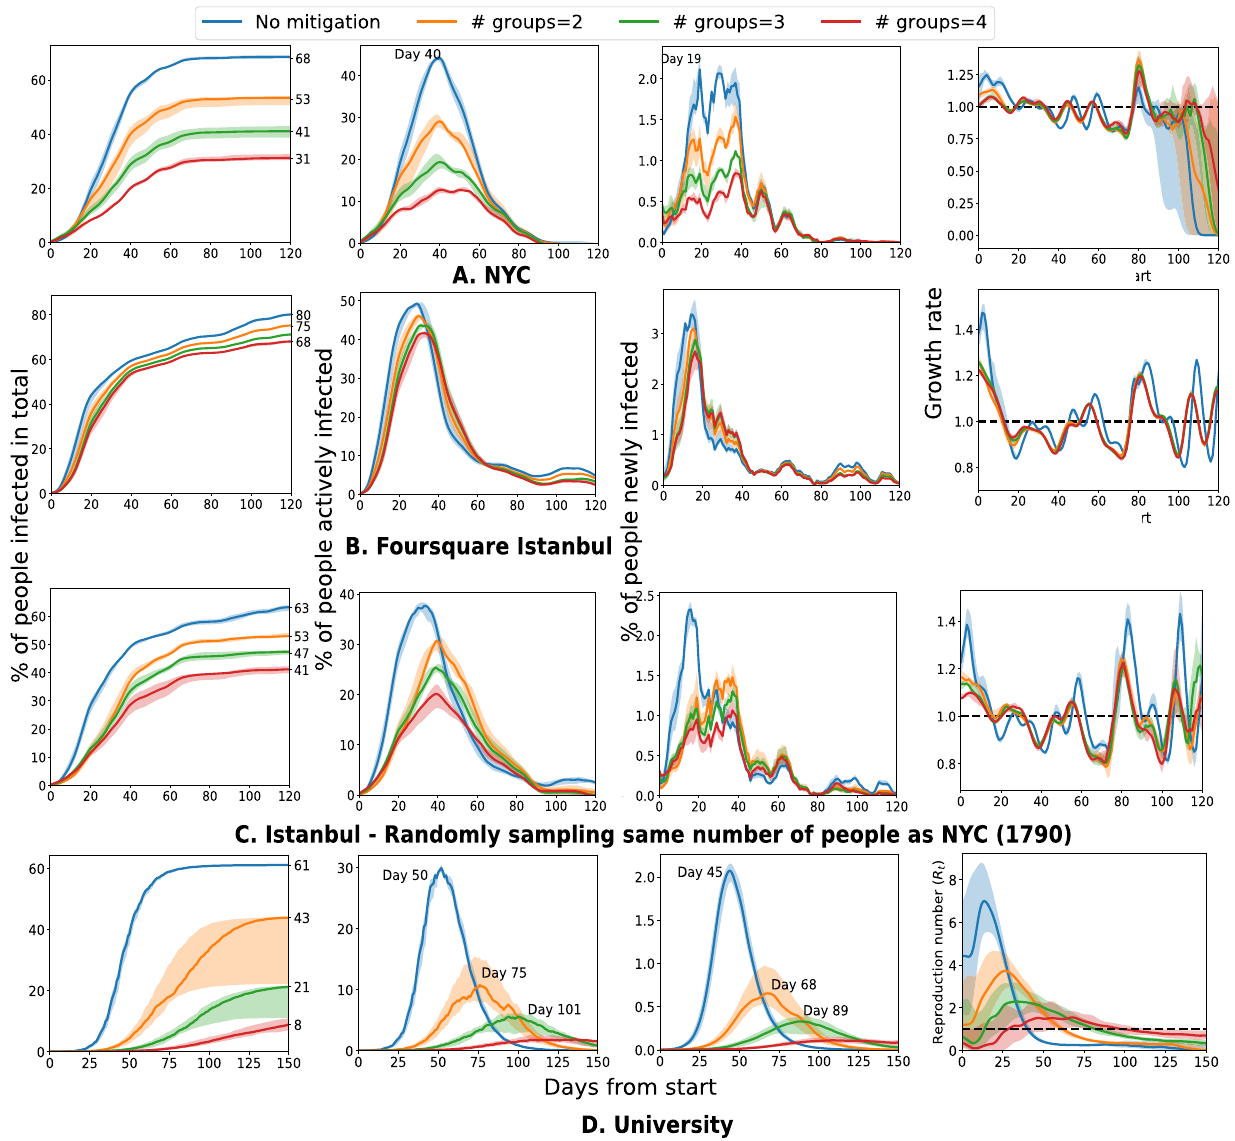
Figure 6. Diving agents into cohorts cuts off the contacts between different cohorts, like separating students into different sessions for courses and acts to reduce the spread of the disease. With the more groups, the number of infected people is reduced (by 37% in NYC and by 53% in the university with 4 groups). The large population of the Istanbul dataset produces densely connected groups that result in substantial intra-group infection spread ( B ). Thus, when we sample the same number of people as NYC, the effect of separating groups re-appear ( C ). In addition, the peaks of active cases are also delayed and flatten, especially in the University